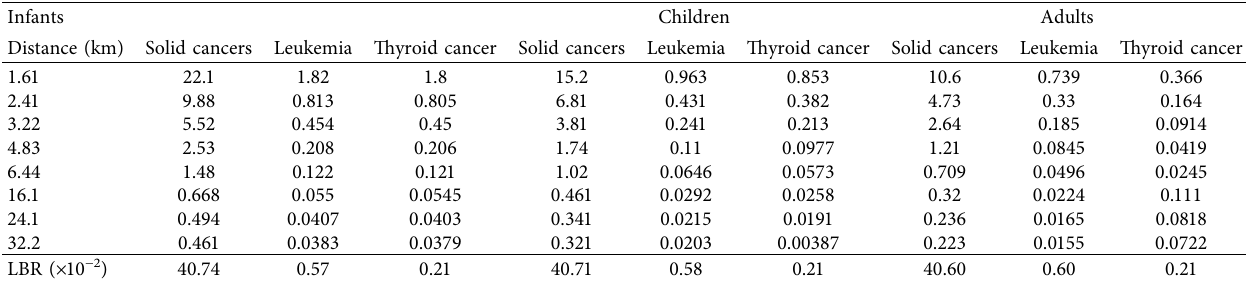
Table 3: LAR (10 − 2 ) of males per 100,000 exposed persons.